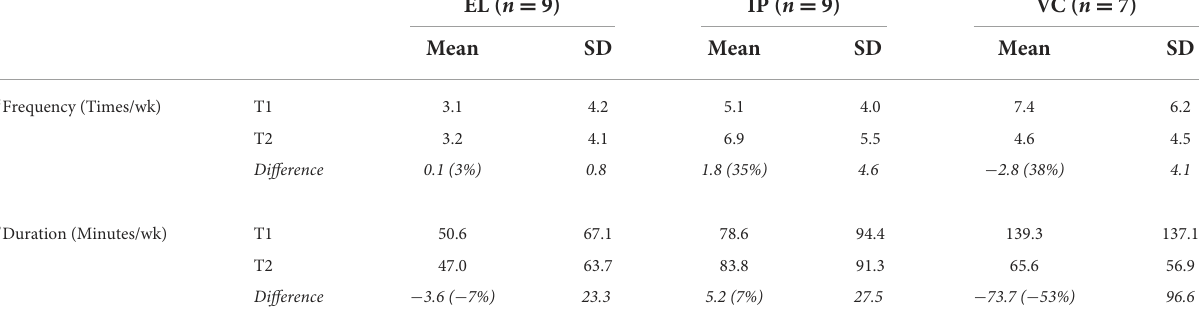
TABLE 6 Comparison of practice frequency and